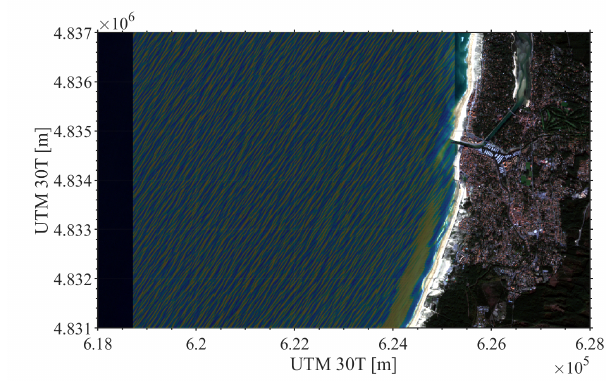
Figure 5. Radon-filtered wave pattern (normalized) from Sentinel-2 imagery collected on 20 November 2017. The filtered image clearly shows the incident wave pattern in the appropriate